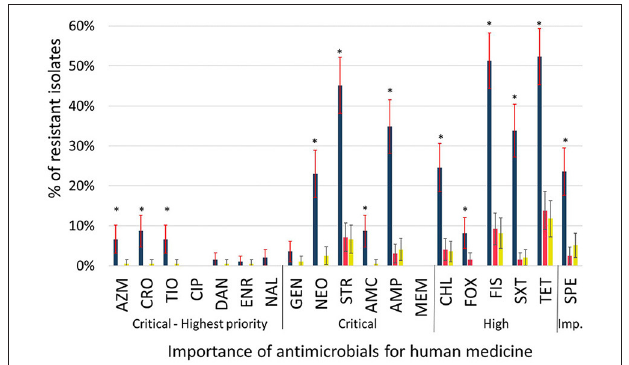
FIGURE 3 | Proportion of resistant (intermediate and resistant combined) Escherichia coli isolated from calves ( ; n = 195), cows ( ; n = 202), and manure pits ( ; n = 196) from 101 dairy farms from Québec, Canada. Error bars represent 95% confidence intervals. Importance of antimicrobial for human medicine according to World Health Organization (15). *Statistically different ( p < 0.05) probabilities of resistance between isolates obtained from calves, cows, or manure pit and estimated using either a logistic regression model with robust variance to account for clustering by farm (AMP, CHL, FIS, SPT, STR, SXT, TET), or a Fisher exact test (AMC, AZM, CRO, DAN, ENR, FOX, GEN, NAL, NEO, TIO). AMC, amoxicillin-clavulanic acid; AMP, ampicillin;